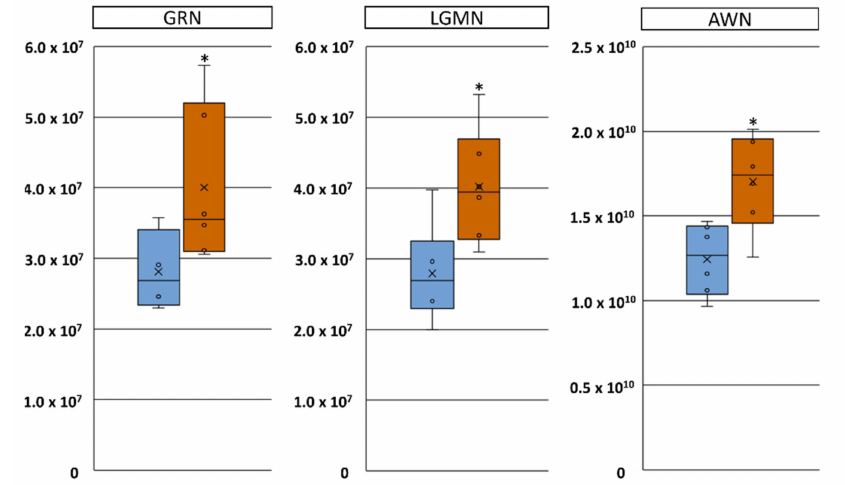
Figure 6. Proteins being significantly altered in abundance in seminal plasma of boars showing high sperm quality (resistant) and low sperm quality (sensitive) in stored semen doses containing 10% ( v / v ) autologous seminal plasma. Box plots of granulin (GRN), legumain (LGMN) and AWN intensity values in seminal plasma samples collected from ejaculates with resistant (blue boxes) and sensitive (orange boxes) sperm. * p <